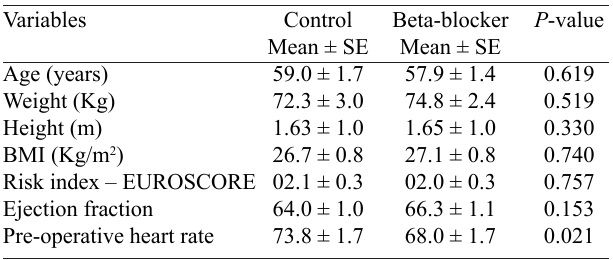
Table 2. Quantitative variables, comparison of the control and beta- blocker groups.